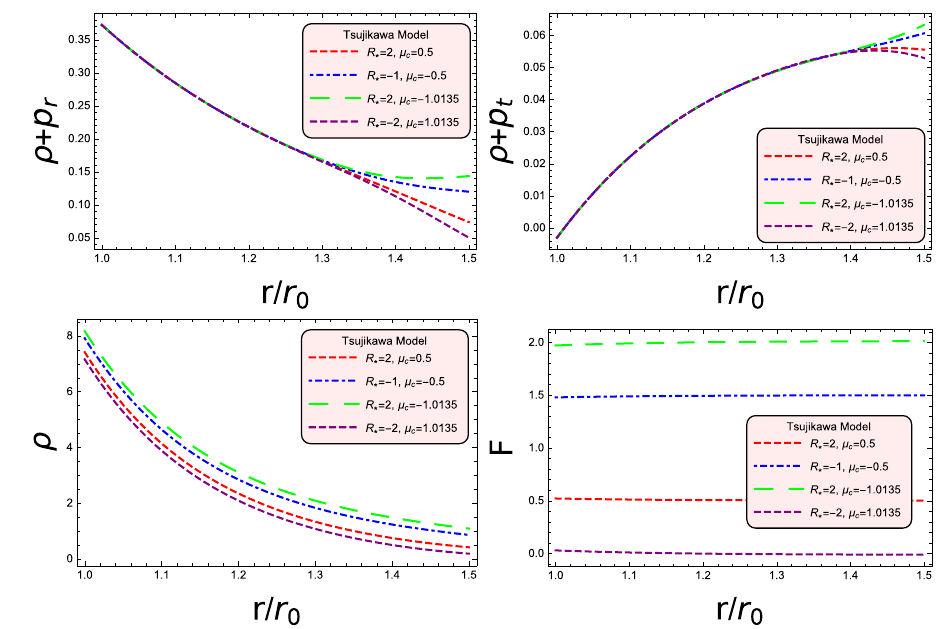
Fig. 7 The both terms of NEC ρ + p ρ + p r (upper left) and t (upper right) are respected at the throat for wormhole geometry for all the considering combinations of free parameters. The first term of WEC ρ (lower left) also shows the validation at the throat. While, we get the violation of non-existence theorem when R ∗ < 0 and μ > 0 (lower c